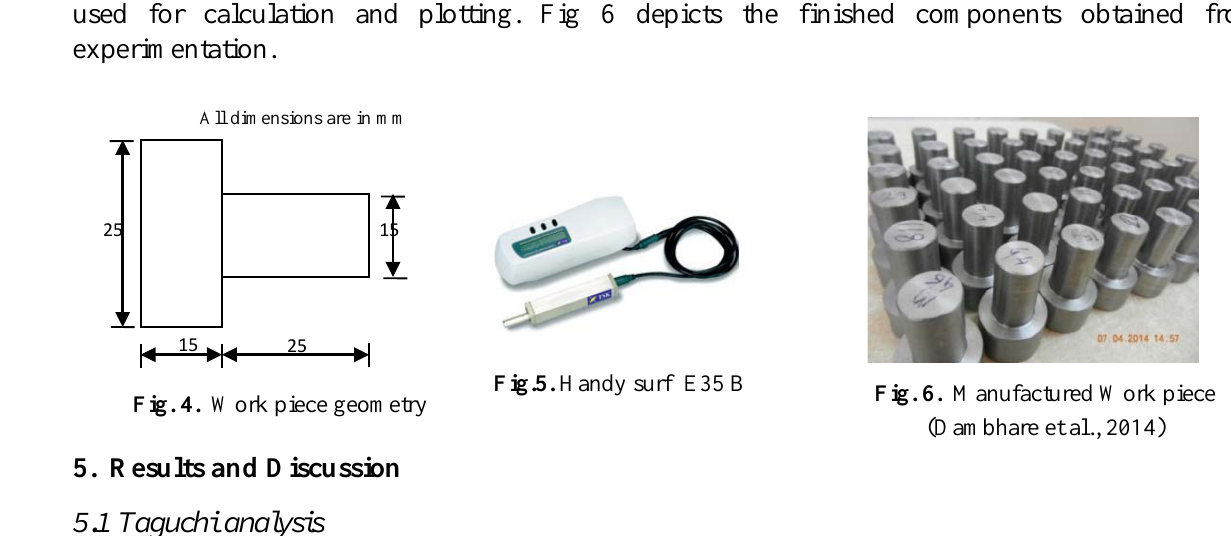
Fig. 6. Manufactured Work piece (Dambhare et al.,